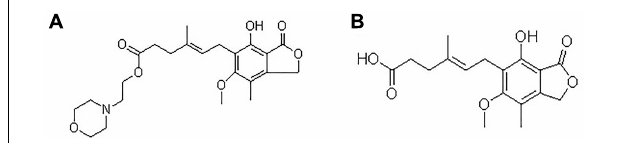
FIGURE 1 | Chemical structures of MMF (A) and MPA (B)